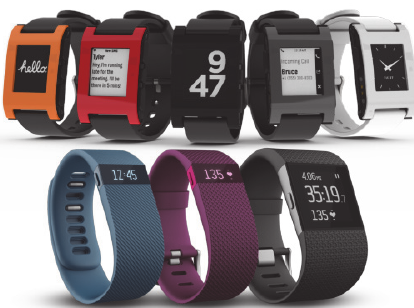
Figure 4: Smart watches and fitness trackers (source:https://www .pebble.com/ and http://www.fitbit.com/).